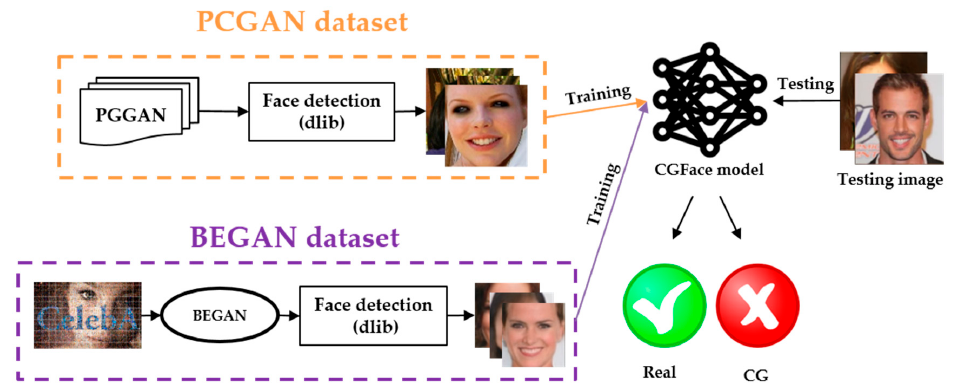
Figure 2. Overall architecture of the proposed method.